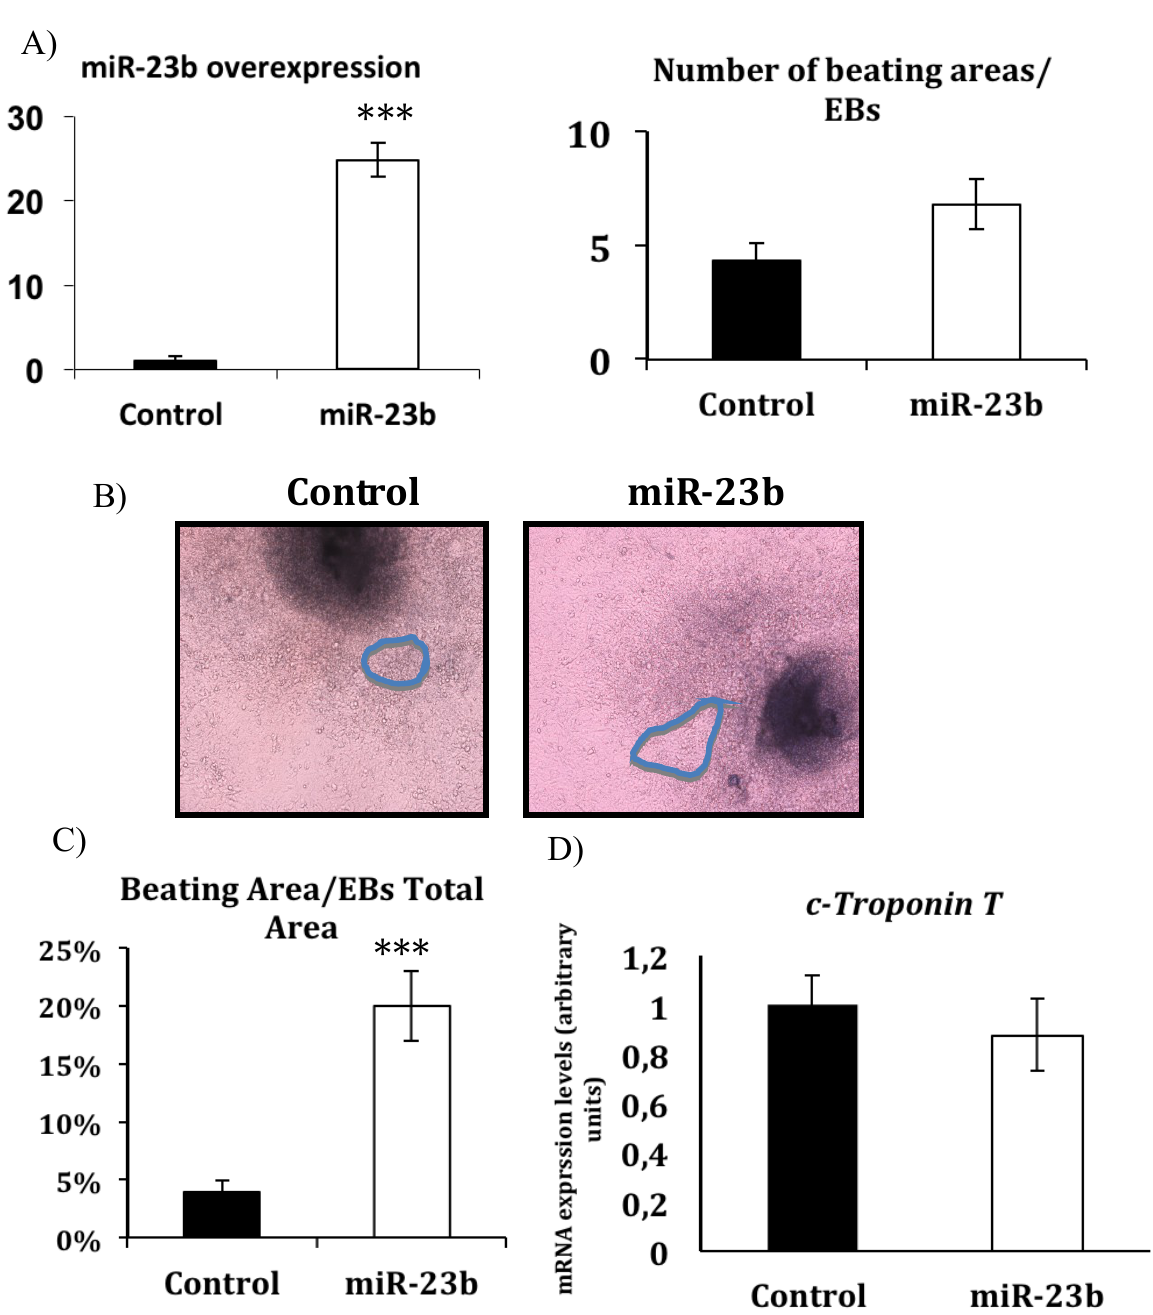
Figure 2. ( A ) Overexpression of miR-23b in EBs derived from murine ESCs analyzed by RT-PCR and number of beating areas in EBs overexpressing miR-27b respect to control. ( B ) Representative image showing the size of beating areas in EBs overexpressing miR-23b respect to control. ( C ) Percentage of the size of beating areas respect to total area of EBs (n = 20). ( D ) c-Troponin T expression profiles on EBs overexpressing